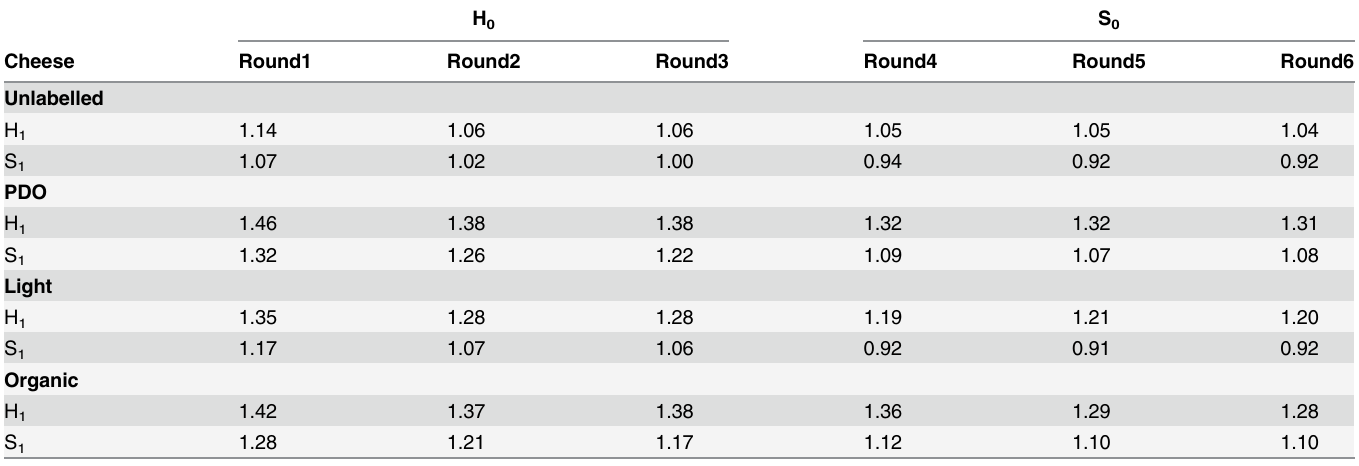
Table 4. Mean bids ( € /100 grams) for each cheese across treatments.